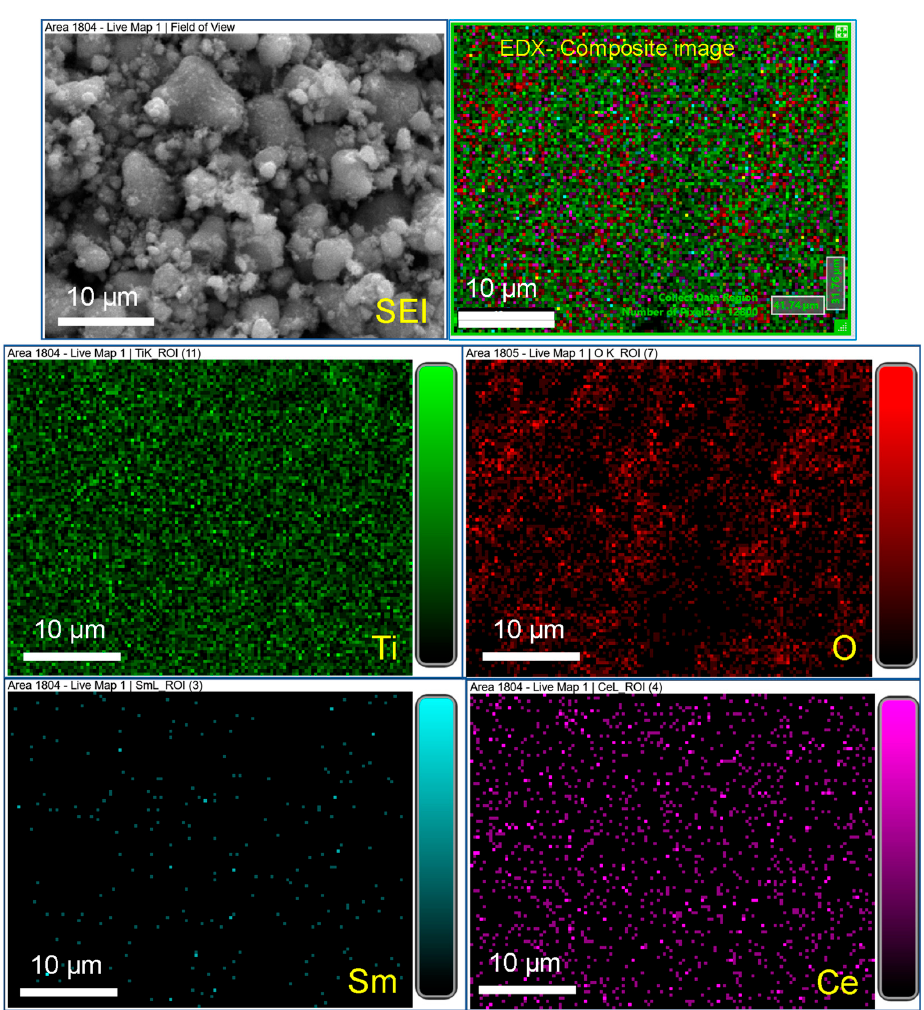
Figure 4. Elemental mapping images of x = 1% composition of Ce–Sm co-doped TiO 2 nanoparticles.